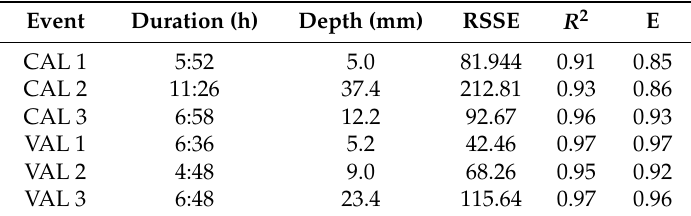
Table 3. Summary and goodness-of-fit measures of the rainfall events used for the stormwater model calibration and validation of the study catchment [59].